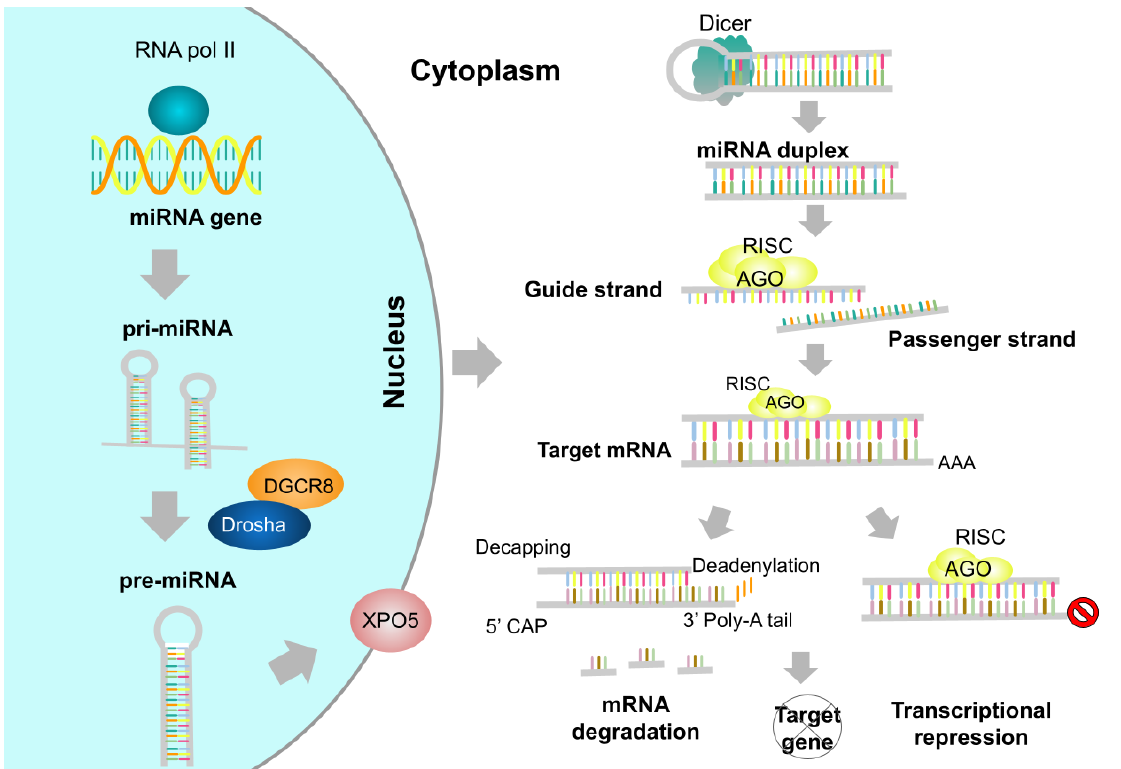
Figure 1. miRNA biogenesis pathway. The pri-miRNA is transcribed in the nucleus by RNA polymerase II and is subsequently converted into pre-miRNA by the Drosha complex and DGCR8. Following this, XPO5 has transported it into the cytoplasm, where the Dicer enzyme removes the hairpin loop, thus forming the miRNA duplex. Afterward, the duplex strands are separated, and the guide strand forms the RISC complex with AGO. Finally, the RISC complex binds to the respective target mRNA and either degrades or represses it.